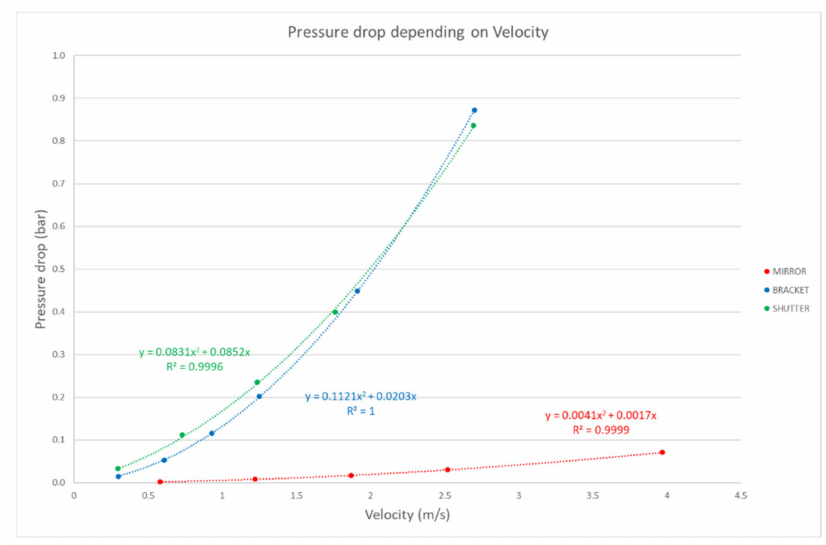
Figure 17. Pressure drop depending on